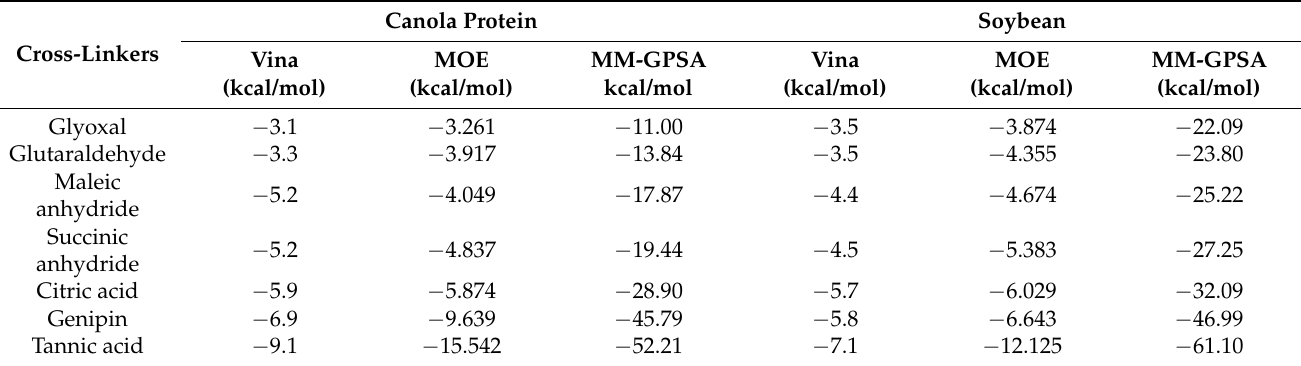
Table 3. Binding energies of protein–cross-linker